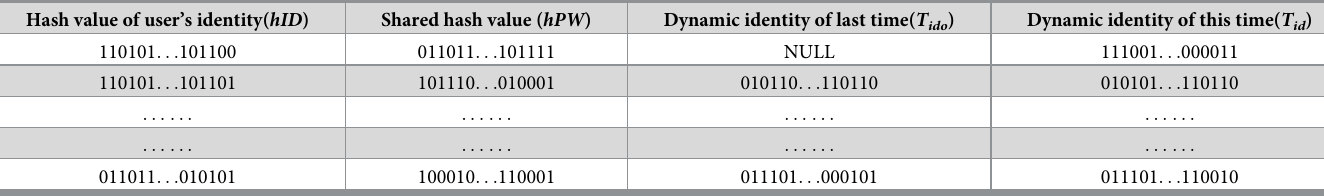
Table 2. Dynamic verification